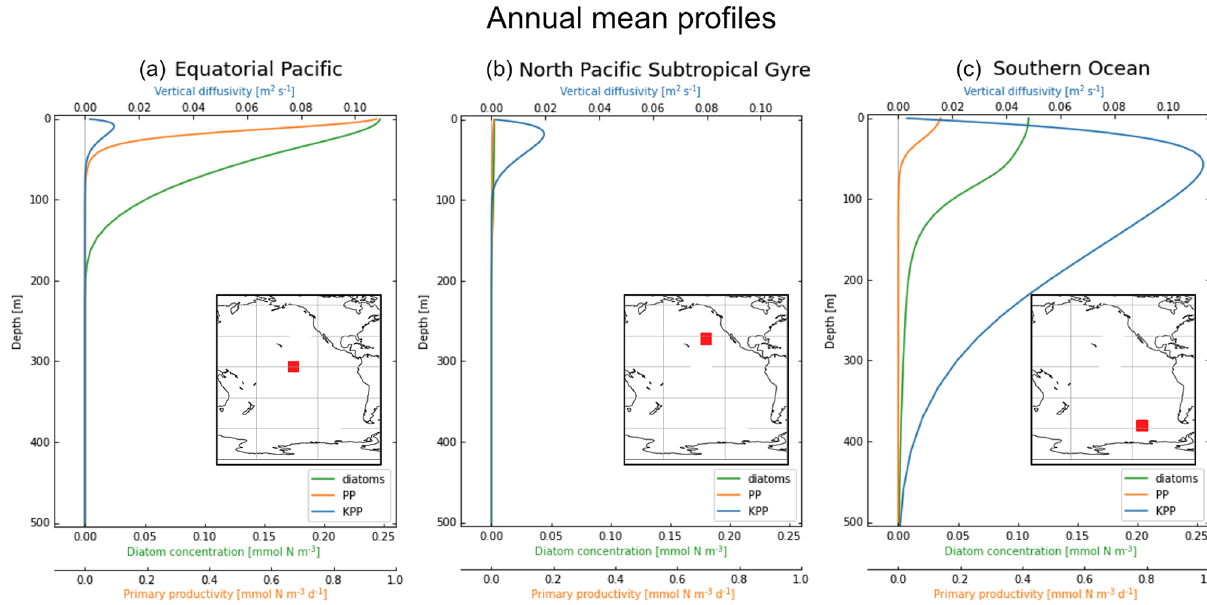
Figure 1. Vertical profiles averaged over 2004 of KPP vertical mixing in blue (m 2 s − 1 ; top x axis), diatom concentration in green (mmolNm − 3 ; bottom x axis) and primary productivity (PP) in orange (mmolNm − 3 s − 1 ; bottom x axis). The profiles are also averaged horizontally in each 10 × 10 ◦ location: (a) equatorial Pacific, (b) North Pacific Subtropical Gyre and (c) Southern Ocean, with the exact release locations shown by the red boxes in the embedded